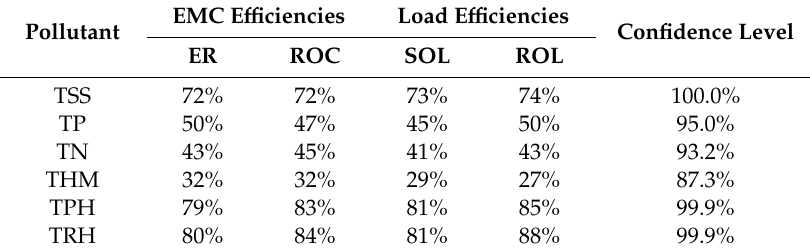
Table 9. E ffi ciency results for Ecosol Storm Pit (Class 2).